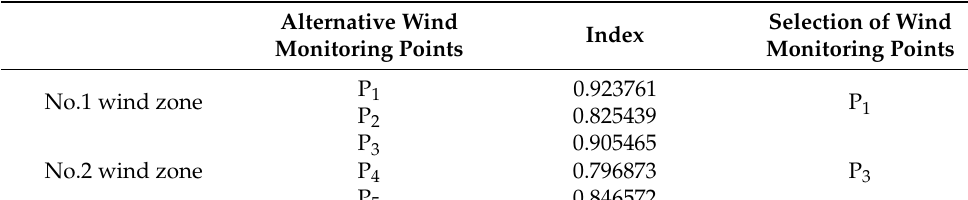
Figure 11. Convergence curves of discrete particle swarm optimization algorithm. Table 3. Screening results of alternative wind monitoring points.